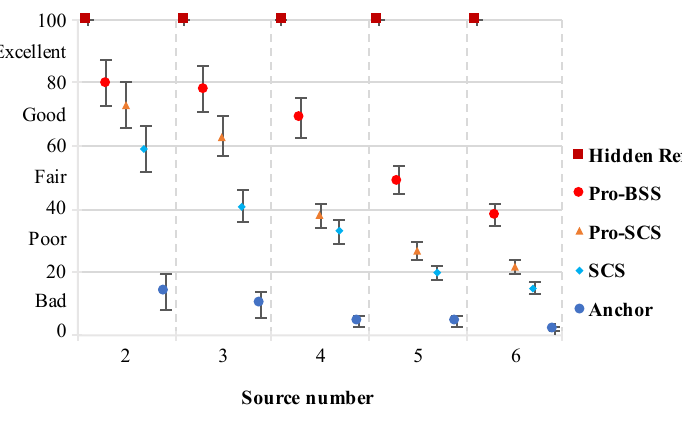
Figure 13. MUSHRA test results of separation = 30 ◦ . Error bars with 95% confidence